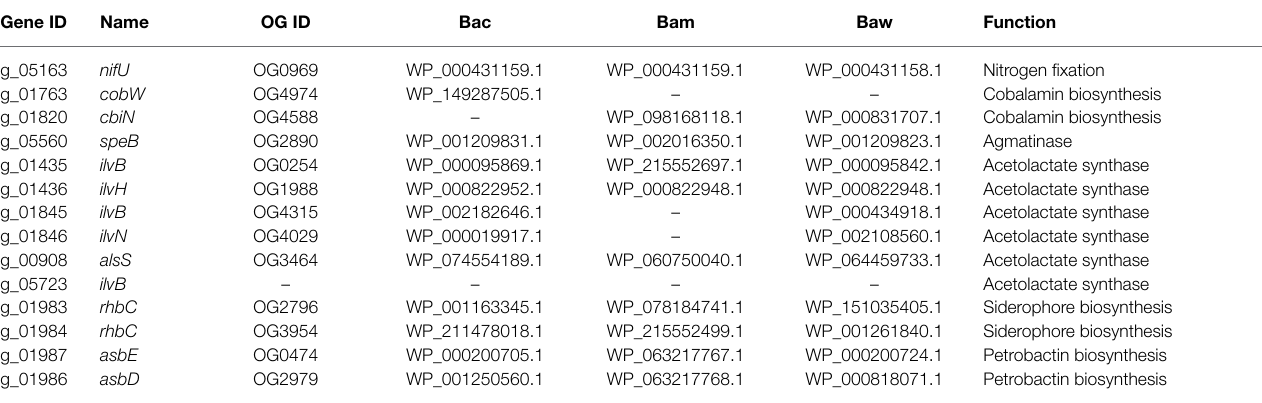
TABLE 4 | Predicted genes associated with plant growth promotion in PGP15 and the three other